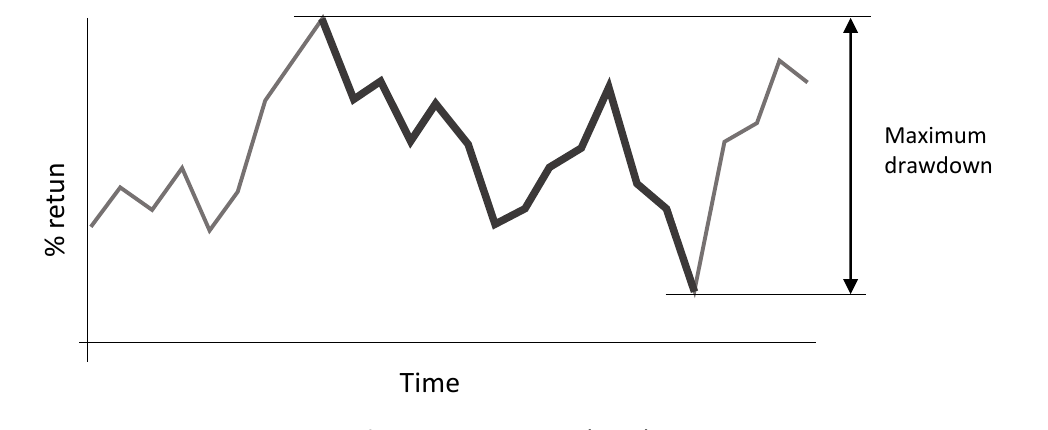
Figure 1. Maximum